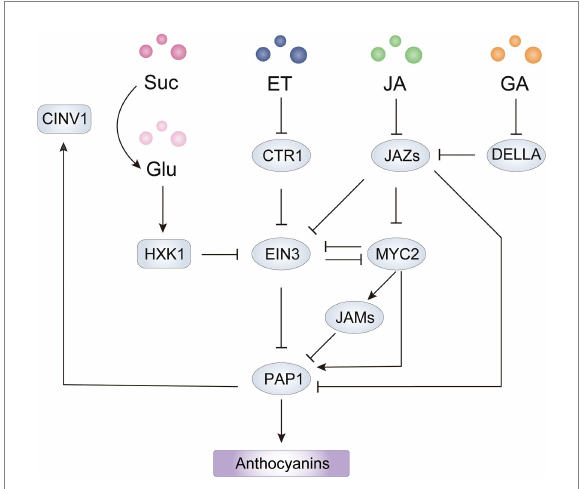
FIGURE 5 Integrated network of sugar and hormones involved in anthocyanin biosynthesis mediated by PAP1 in Arabidopsis . The HXK1-EIN3-PAP1 cascade forms a positive feedback loop for sugar induced anthocyanin biosynthesis. The point(s) of convergence of EIN3-dependent sucrose, ET, and JA signaling pathways lead to transcriptional regulation of PAP1. The JAZ- MYC2 module acts as an integrated node of ET, GA and JA signaling pathways for regulation of PAP1 at the transcriptional and translational level. HXK1, hexokinase 1; CINV1, cytosolic invertase 1; ET, ethylene; JA, jasmonate; GA, gibberellin; Suc, sucrose; Glu,